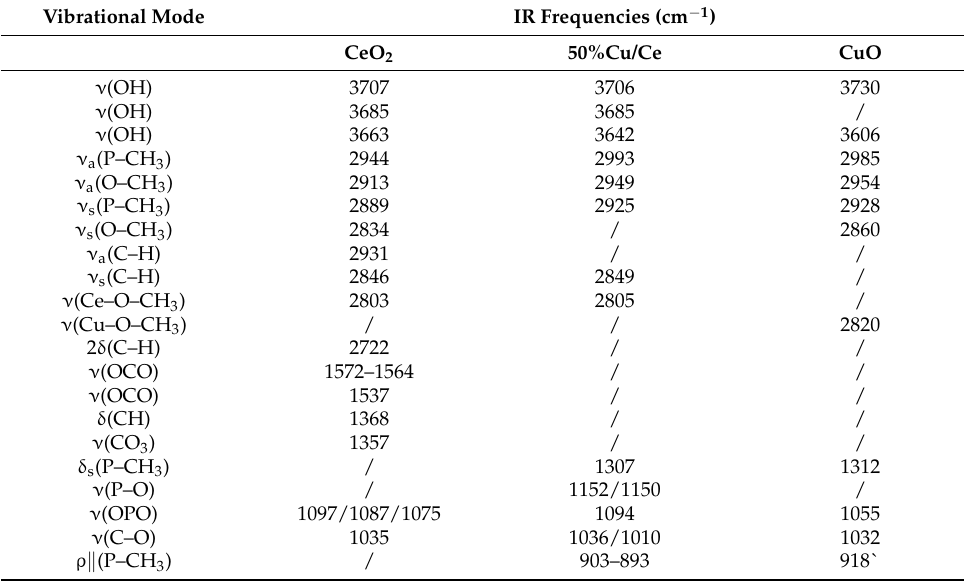
Table 9. IR frequencies and assignments of the surface